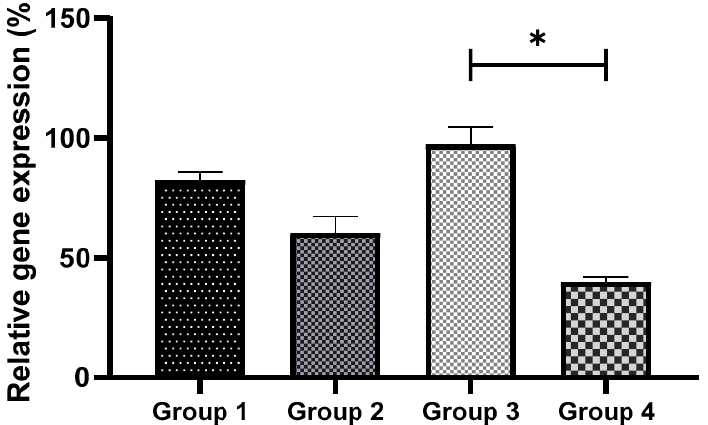
Figure 9. The effect of GSH supplementation on pro-apoptotic Bax gene expression in non-vitrified and vitrified groups. Data are expressed as the means ± SEM. * p < 0.05. Group 1 (GSH-free medium); Group 2 (GSH-supplemented medium); Group 3 (GSH-free medium with vitrification); Group 4 (GSH-supplemented medium with vitrification).